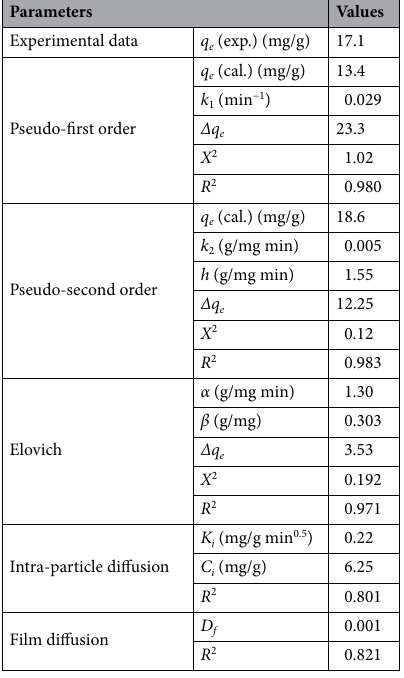
Table 4. Kinetic model parameters of the biosorption of Cu 2+ ions onto R. damascena